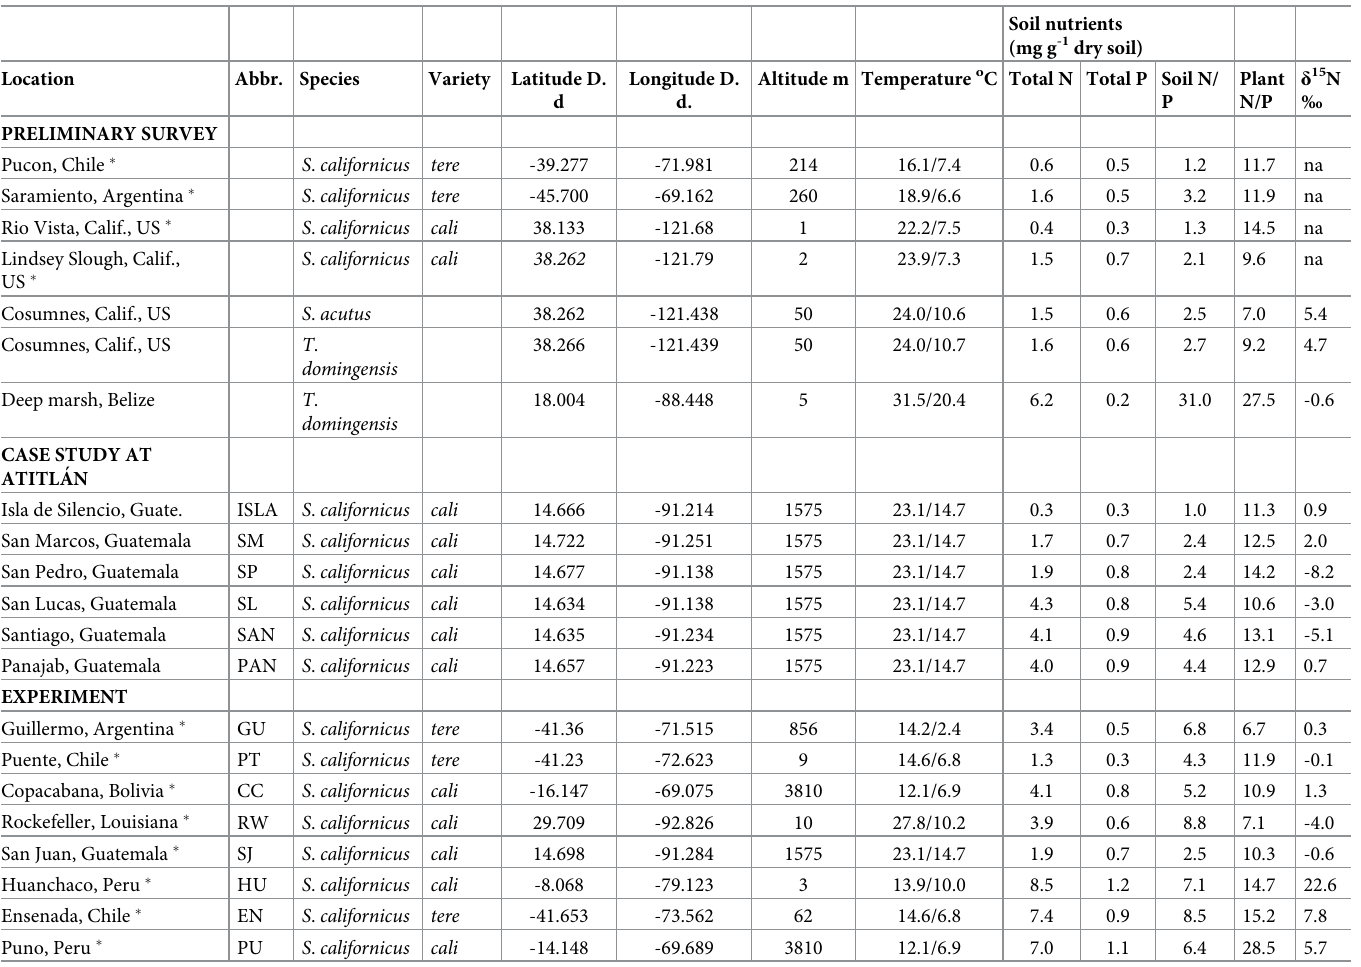
Table 2. Characteristics of sampling locations for Schoenoplectuscalifornicus ; tere = variety tereticulmis ; cali = variety californicus